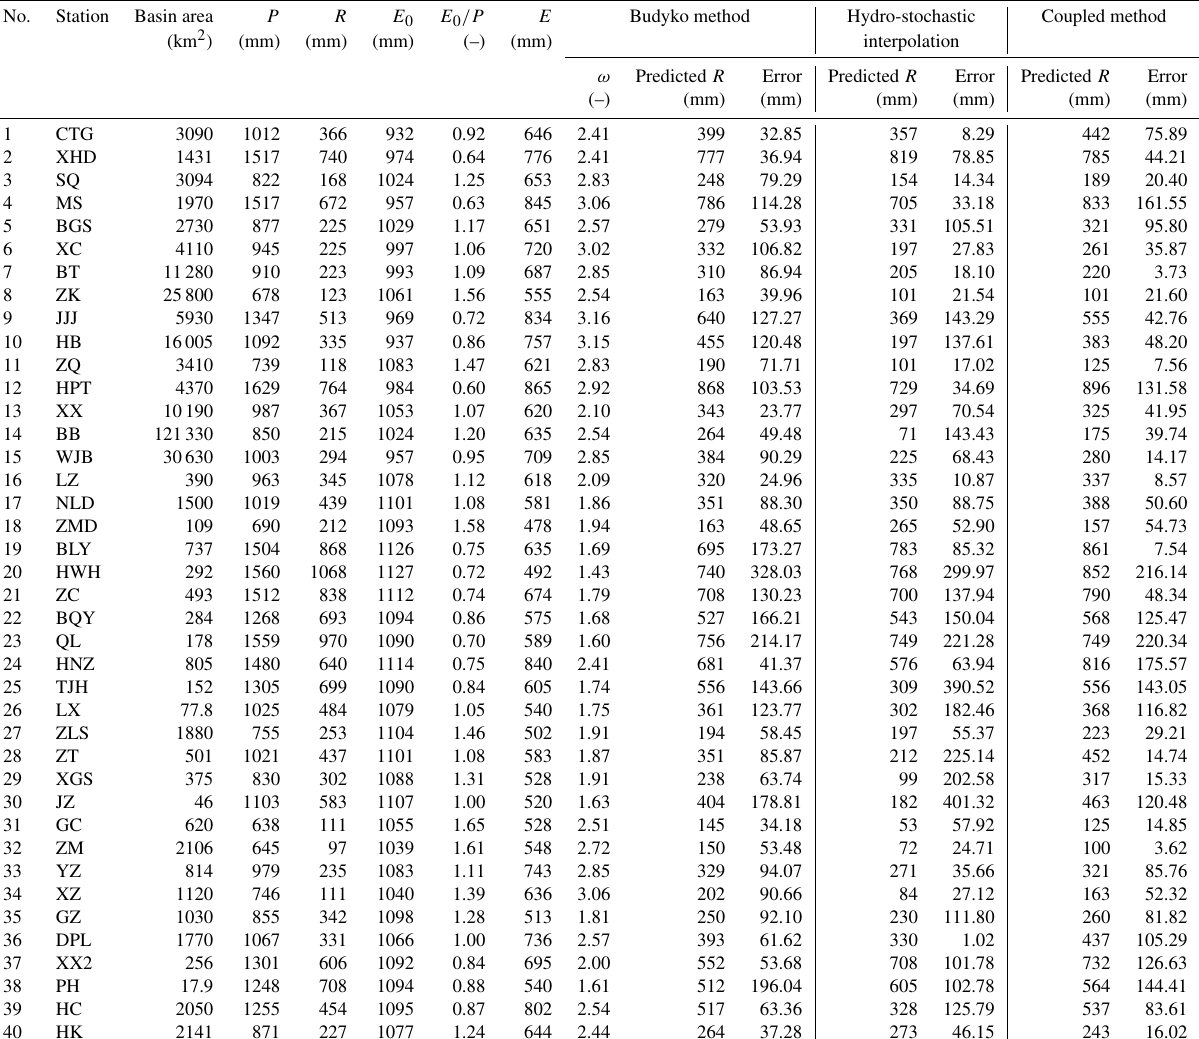
Table 1. Summary of hydro-meteorological data and predicted runoff of the sub-basins in the HRB.